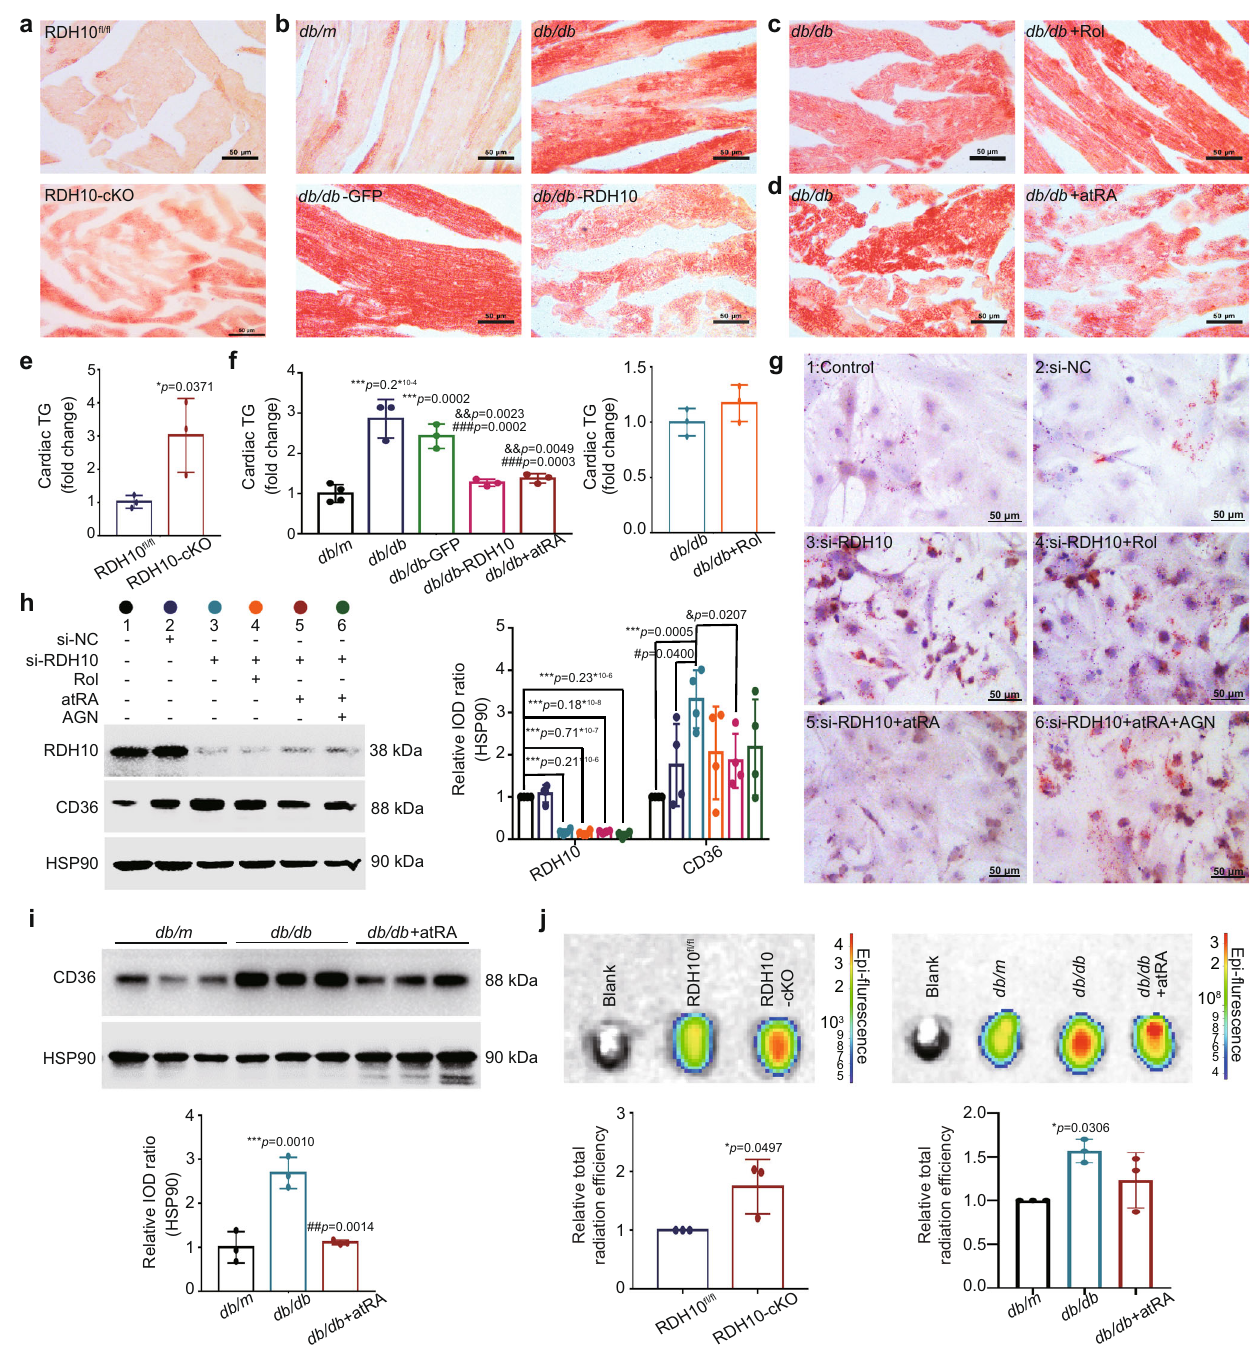
db ;& vsdb/db -GFP. g OilredOstainingofNeonatalmouseprimarycardiomyocytes (NMPCs). h WB ofCD36 inNMPCs, n =4,* vs 1; # vs 2;& vs 3. i WB of cardiac CD36, n =3,* vsdb/m ;# vsdb/db . j CardiacFFAsuptakecapacitydetectionofRDH10-cKO mice and db/db mice with atRA, n =3, * vs RDH10 fl / fl (RDH10-cKO) or db/m ( db/db ). Data are expressed as means±SD. Two-tailed unpaired t -test was used for the analysis of statistical signi fi cance in ( e ), ( f ) (right) and ( j ) (left) while one-way ANOVAwithTukeyposthoctestwasusedfortheanalysisofstatisticalsigni fi cance in ( f ) (left), ( h ), ( I ) and ( j ) (right). Source data are provided as a Source Data fi